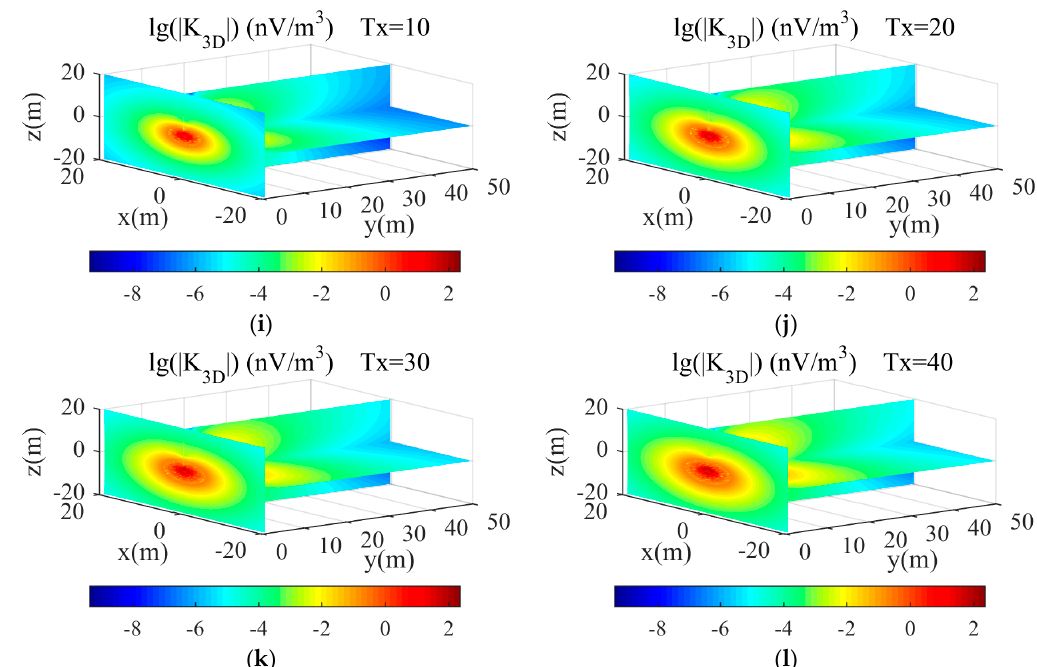
Figure 2. Three-dimensional slices of the kernel model results for underground MRS using a small-coil sensor. The Larmor frequency is 2300 Hz, the resistivity of the surrounding rock is 500 Ω · m, and the coil is positioned vertically in the north-south direction ( α = 0 ◦ , β = 0 ◦ ). ( a – d ) Kernel model results for coil diameters of 1 m, 2 m, 3 m, and 4 m, respectively. 40 turns are assumed for Tx, and 128 turns are assumed for Rx; the geomagnetic inclination is 60 ◦ , and the geomagnetic declination is 0 ◦ . ( e – h ) Kernel model results using a 1-m diameter coil for geomagnetic inclinations of 0, 30, 60, and 90 ◦ , respectively. 40 turns are assumed for Tx, and 128 turns are assumed for Rx; the geomagnetic declination is 0 ◦ . ( i – l ) Kernel model results using a 1-m diameter coil for 10, 20, 30, and 40 coil turns for Tx, and 128 turns are assumed for Rx, respectively. The geomagnetic inclination is 60 ◦ , and the geomagnetic declination is 0 ◦